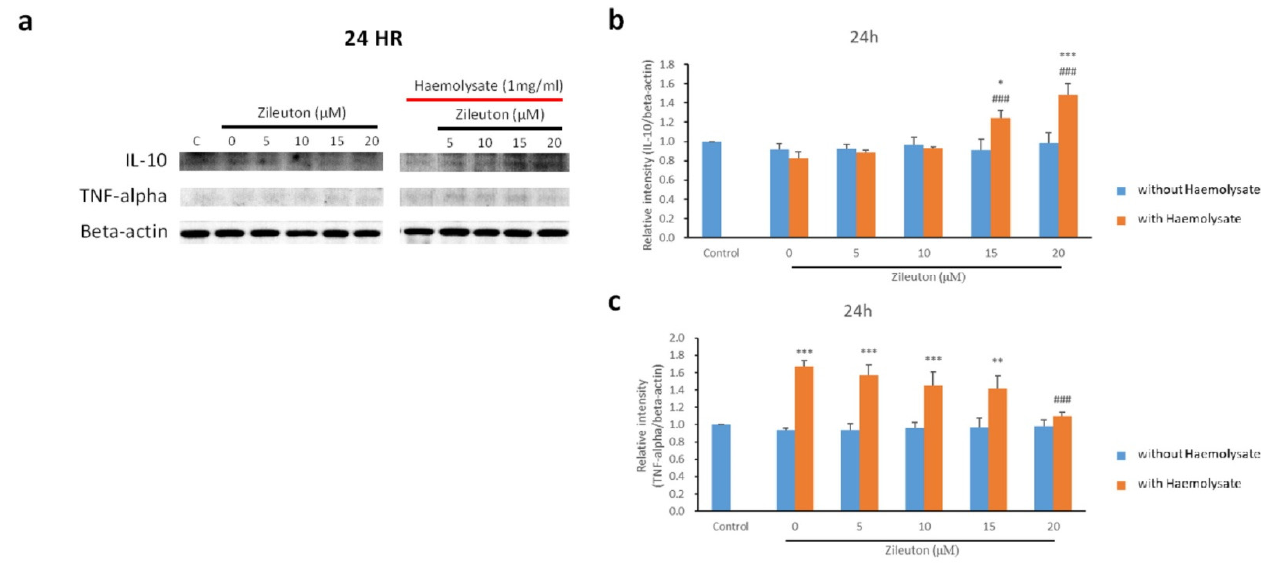
Figure 3. Western blot results for cytokines from BV-2 cells. ( a ) Western blot results for IL-10 and TNF- α . ( b ) Histogram illustrating the Western blot results for IL-10. The differential expression of IL-10 in M1- and M2-polarised BV-2 cells was assessed via Western blot assay to gain insight into the polarisation of BV-2 cells. IL-10 is one of the cytokines expressed on M2 microglia. The x -axis represents the control group, and haemolysate-exposed cells treated with the vehicle and different concentrations of zileuton; the y -axis represents expression levels as the relative intensity of protein bands that appeared in the Western blot assay. Haemolysate-exposed BV-2 cells treated with 15 and 20 µ M of zileuton had a significantly higher level of IL-10 than BV-2 cells in the control and haemolysate + vehicle groups (* p < 0.05, *** p < 0.001 compared with control; ### p < 0.001 compared with haemolysate + vehicle group, n = 3). ( c ) Histogram illustrating the Western blot results for TNF- α . Western blot assay was employed to measure the expression level of TNF- α , which is a representative cytokine released by M1 microglia. The haemolysate-exposed BV-2 cells treated with the vehicle, as well as 5, 10, and 15 µ M zileuton, had a higher expression level of TNF- α than BV-2 cells in the control group. Following treatment with 20 µ M zileuton, the expression level of TNF- α decreased significantly compared with that of BV-2 cells in the haemolysate + vehicle group ( p < 0.001). However, there was no significant difference between the haemolysate + 20 µ M zileuton group and the control group (** p < 0.01, *** p < 0.001 compared with control; ### p < 0.001 compared with the haemolysate + vehicle group, n =